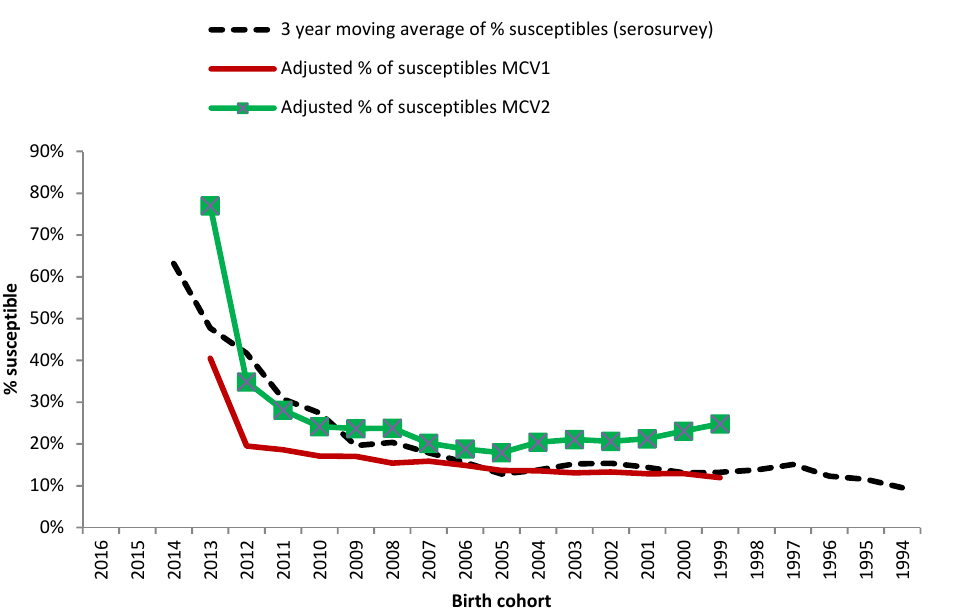
Figure 3. Proportion of susceptible persons by birth cohort (1994–2014): comparison of 3-year moving average susceptibility levels of seroprevalence data, adjusted vaccine coverage data for one or two doses of a measles containing vaccine (MCV), assuming a vaccine effectiveness of 93% for the first and 97% for the second dose.